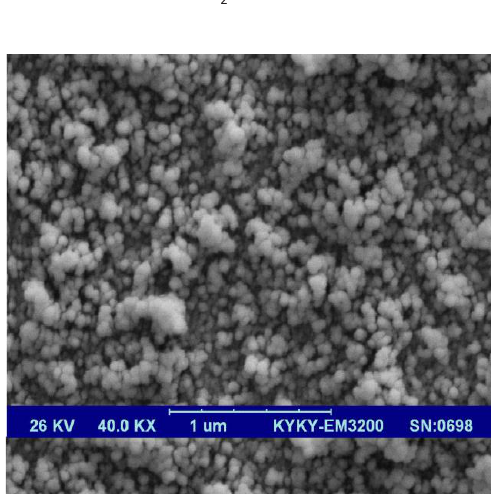
O nanoparticles synthesized at 2 4